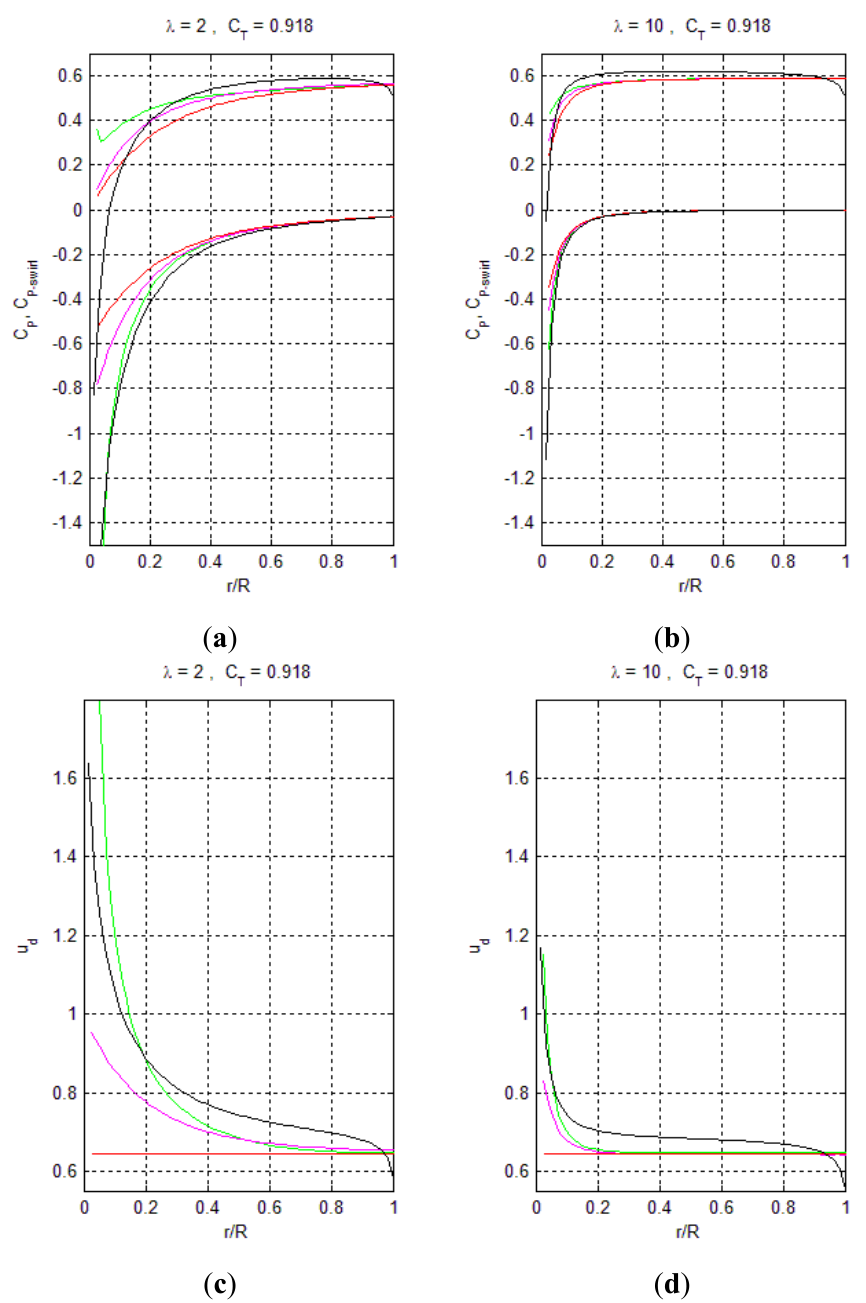
Figure 10. BEM (colored) and AD (black) spanwise distribution of power (upper) and mass-flow (lower) at high thrust loading, C ( b , d ) TSR =